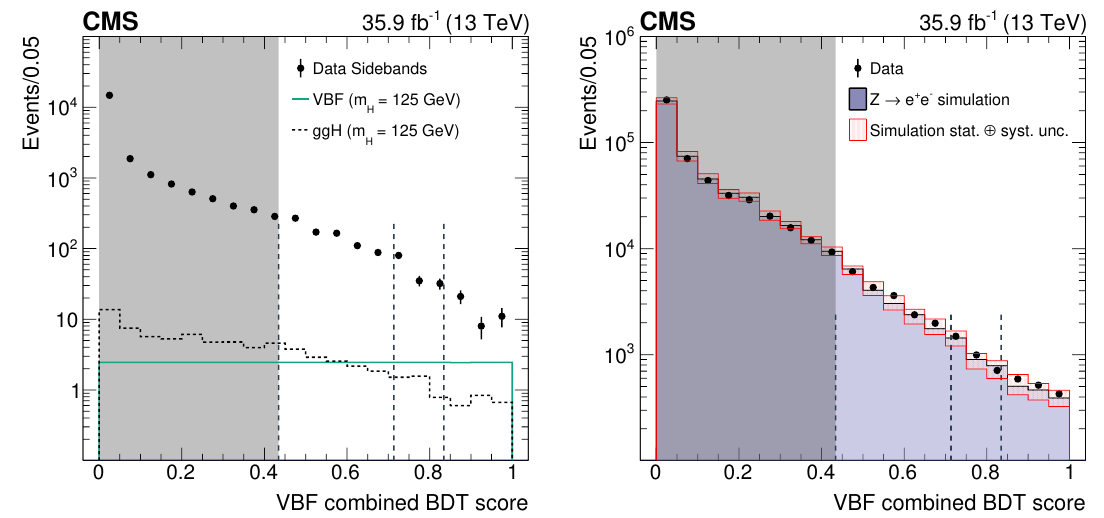
Figure 7 . Score distribution from the VBF combined BDT for (left) ggH and VBF signal dis- tributions, compared to background taken from data in the mass sideband regions, and (right) Z ! e + e (cid:0) + jets events. On the left, the signal region selection is applied to the simulated ggH and VBF events; these are compared to points representing the background, as determined from data using the signal region selection in mass sidebands. On the right, the signal selection is applied to electrons reconstructed as photons, with points showing the distribution for data and the histogram showing the distribution for simulated Drell-Yan events, including statistical and systematic uncer- tainties (pink band). In both plots, dotted lines delimit the three VBF categories, while the grey region is discarded from the